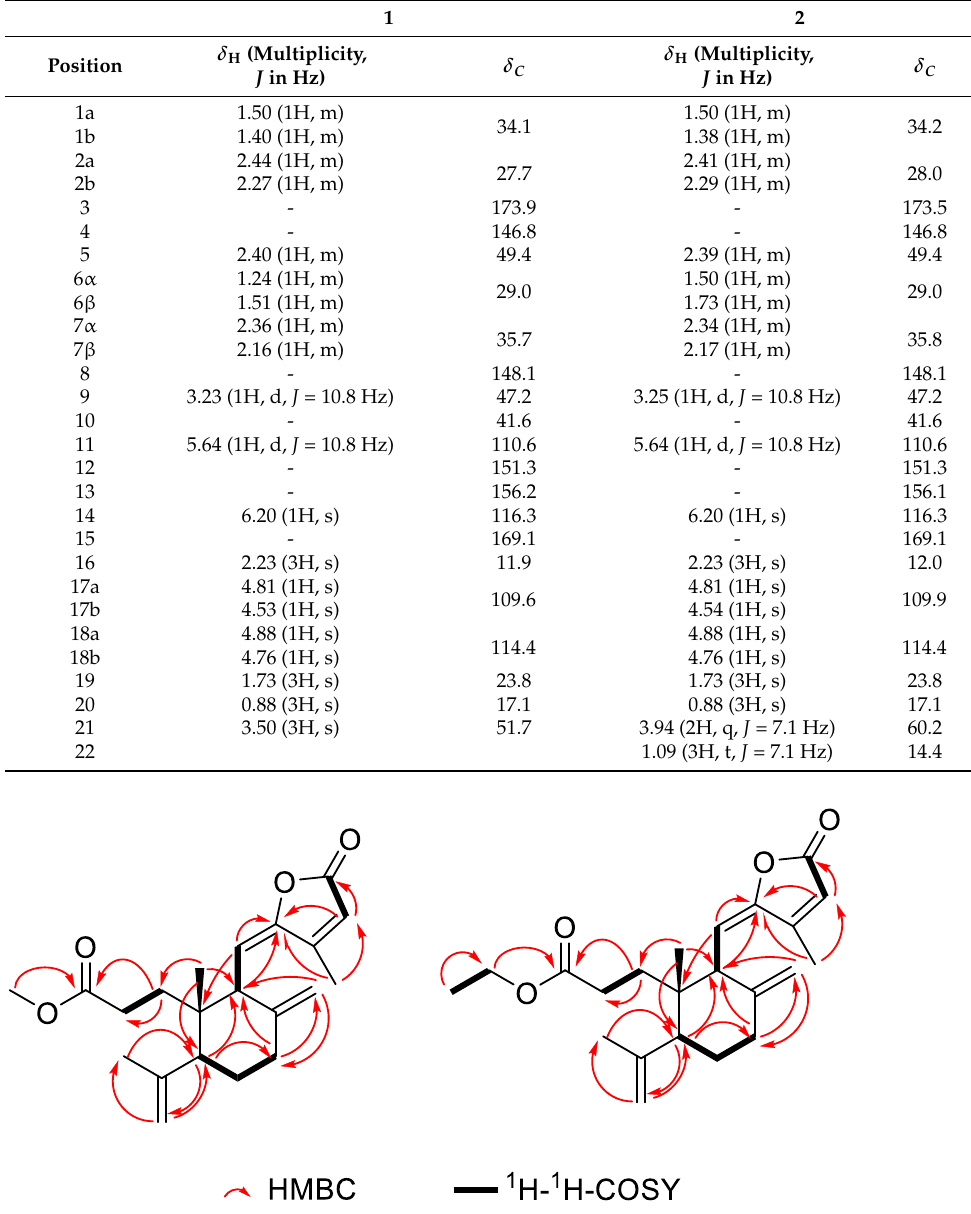
Table 1. 1 H (400 MHz) and 13 C-NMR (100 MHz) spectral data of 1–2 in DMSO- d 6 .